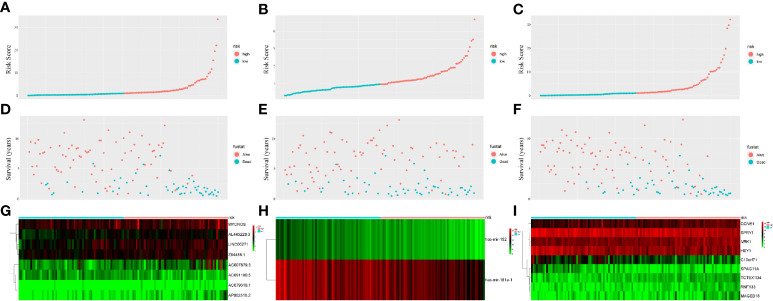
Prognostic classifier analyses in distinguishing patients into low-risk and high-risk groups. (A) The lncRNA-based risk score distribution of each patient. (B) The miRNA-based risk score distribution of each patient. (C) The mRNA-based risk score distribution of each patient. (D) The lncRNA-based survival status of each patient in two groups. (E) The miRNA-based survival status of each patient in two groups. (F) The mRNA-based survival status of each patient in two groups. (G) Heatmap of lncRNAs expression between two groups. (H) Heatmap of miRNAs expression between two groups. (I) Heatmap of mRNAs expression between two groups.